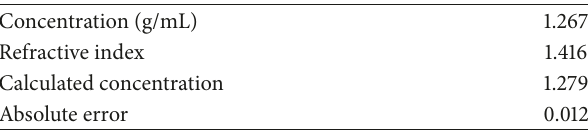
Table 1: Validation of the calibration equation for the spectropho- tometric method.